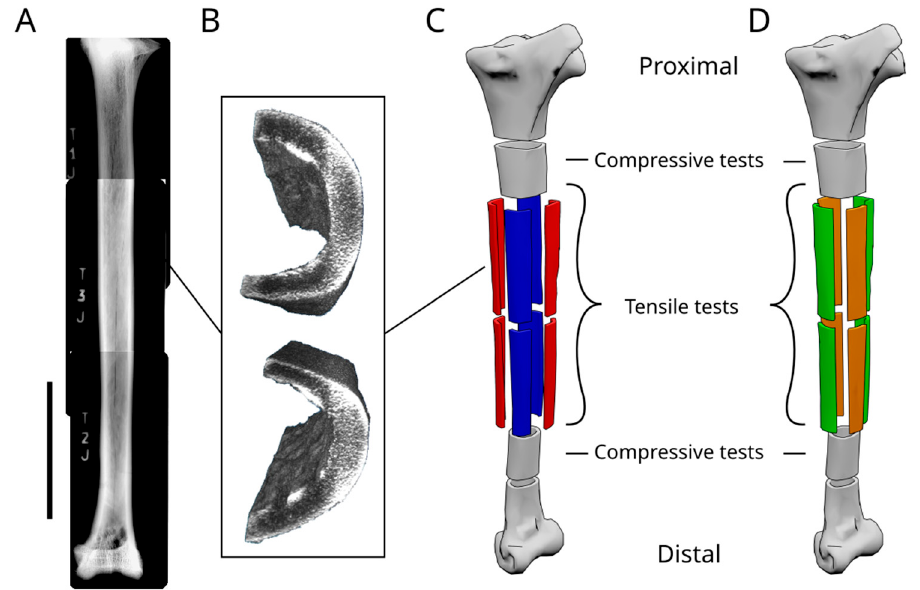
Figure 3. Structure of the ostrich tibia. ( A ) Image composed of multiple radiographic images of an ostrich tibia, showing the internal structure. The scale bar is equal to 10 cm. ( B ) Image obtained from the CTscan data showing the differences in density within the tibial shaft. ( C ) Model of an ostrich tibia showing how the samples are obtained from the dried tibia. ( D ) Model of an ostrich tibia showing how the samples are obtained to perform the mechanical tests.